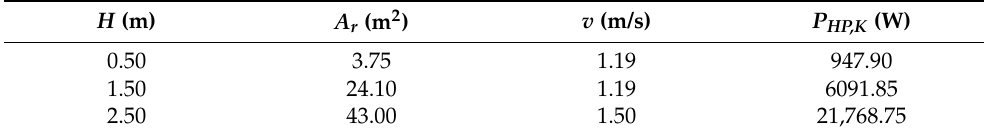
Table 3. Insight into the potential power of the turbines with respect of the kinetic hydro energy for the Bednja River.